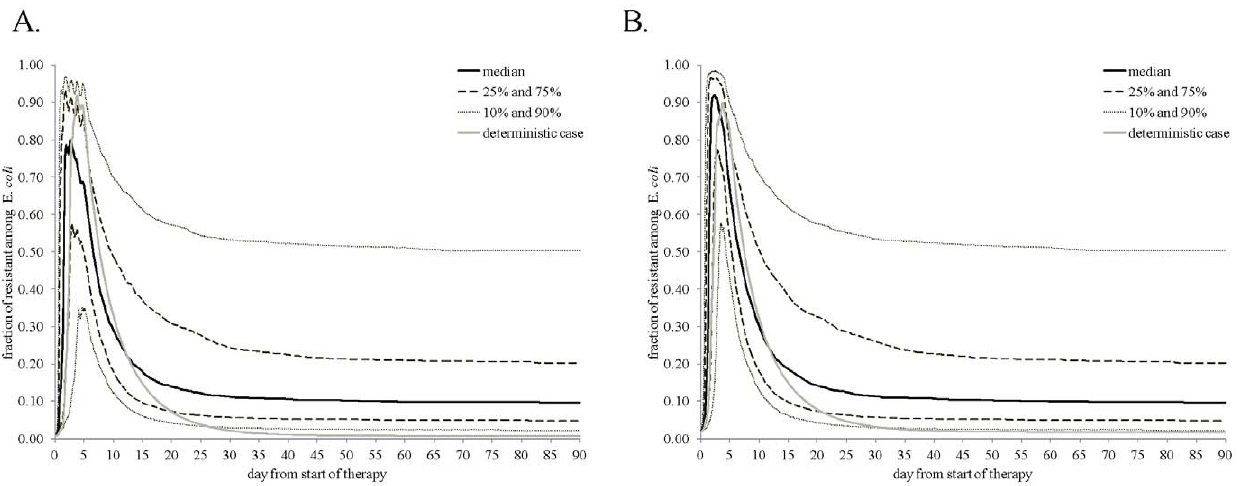
Figure 6. Uncertainty in the fraction of ceftiofur-resistant among enteric E.coli during 90 days from start of therapy. Statistics are for 500 model simulations at each time point randomly varying parameters of bacterial ecology and pharmacodynamics. A: A 5-day repeated ceftiofur administration to an adult dairy (frequency of resistance at start of therapy 0.7%). B: An injection of a sustained-release ceftiofur formulation to a 6- mos beef (frequency of resistance at start of therapy 1.8%).